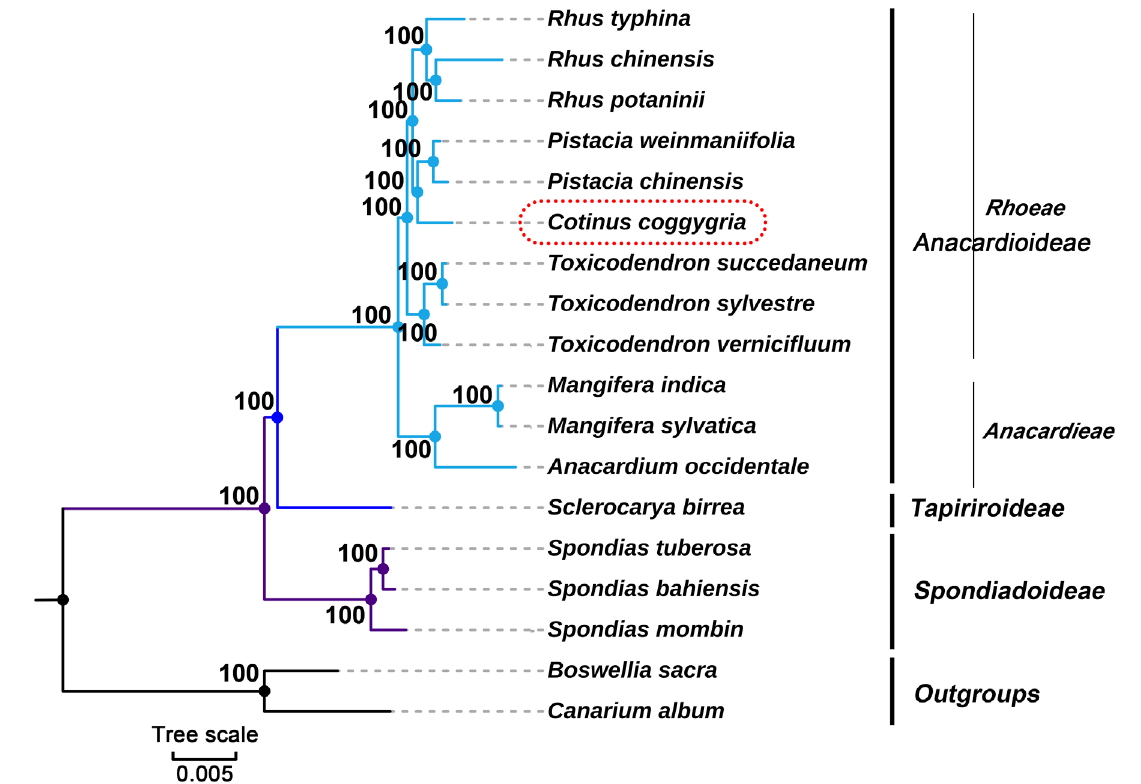
Figure 4 – Phylogenetic relationships of species from Anacardiaceae family inferred using Maximum likelihood (ML) method. The phylogenetic tree was constructed by using the selected conserved blocks based on complete plastome sequences among the 18 plastomes. A total of 1,477 highly conservative blocks were identified by using Gblock with the default setting. Gblocks alignment (138,527 bp) accounts for 71% of the original alignment (194,522 bp). The number at the bottom of the scale, 0.005, means that the length of the branch represents the replacement frequency of bases at each site of the genome at 0.005. Bootstrap values were calculated from 1000 replicates. Two taxa from Burseraceae, namely, B. sacra and C. album were used as